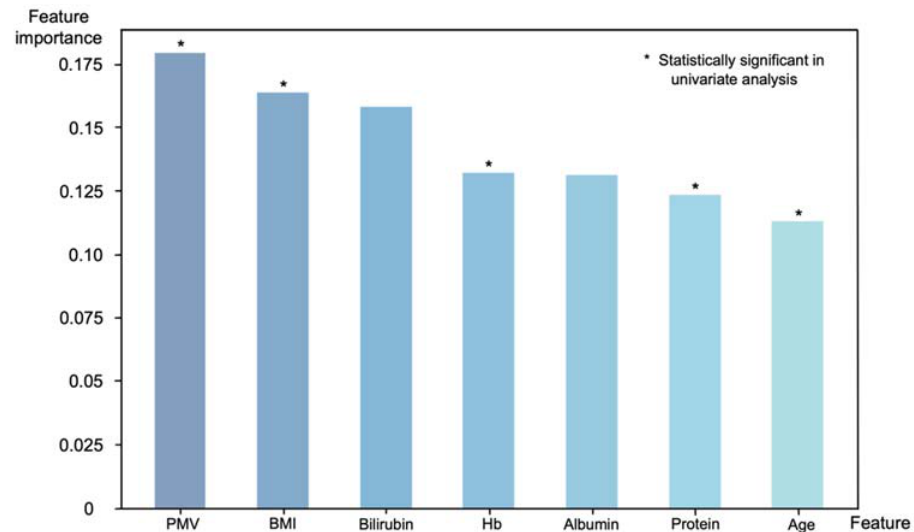
Figure 5. Feature importance with respect to the binary classification of sarcopenia using the XGBoost model. Features that showed statistical significance in a univariate analysis also ranked high in importance in the XGBoost model, with PMV being the most important features.